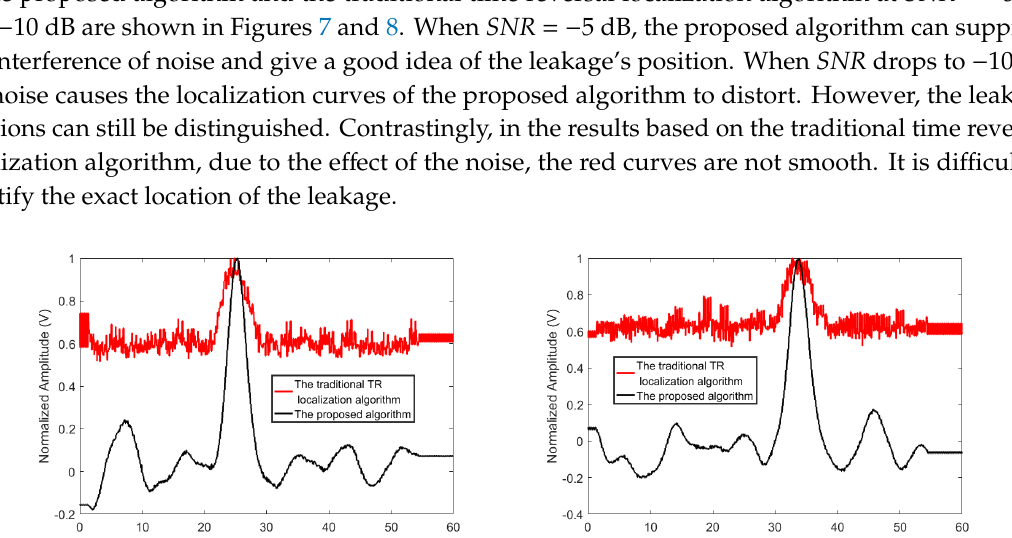
(a) (b) Figure 8. The localization results obtained by using the proposed algorithm and the traditional time reversal localization algorithm at SNR = −10dB, ( a ) L1 and ( b ) L2. SNR = − 5 dB SNR = − 10 dB (a) SNR = − 5 dB SNR = − 10 dB (b) Figure 9. The localization results obtained by using the proposed algorithm and the method (the parameter p = 1) presented in [80] at various SNR s, ( a ) L1 and ( b ) L2.